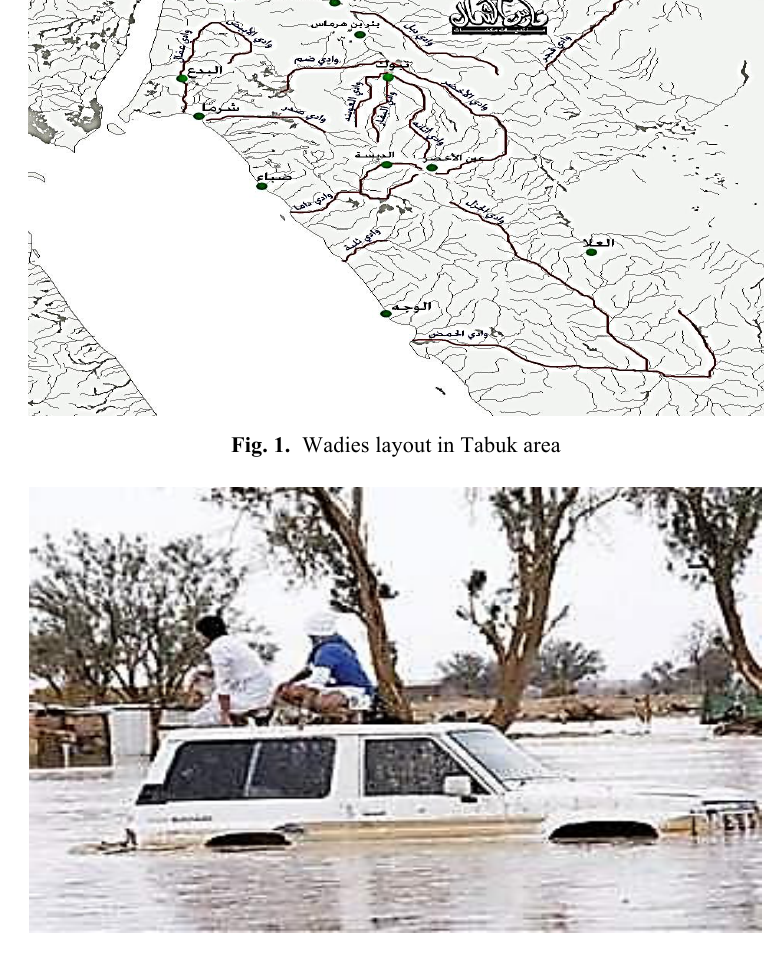
Fig. 2. Wadies layout in Tabuk